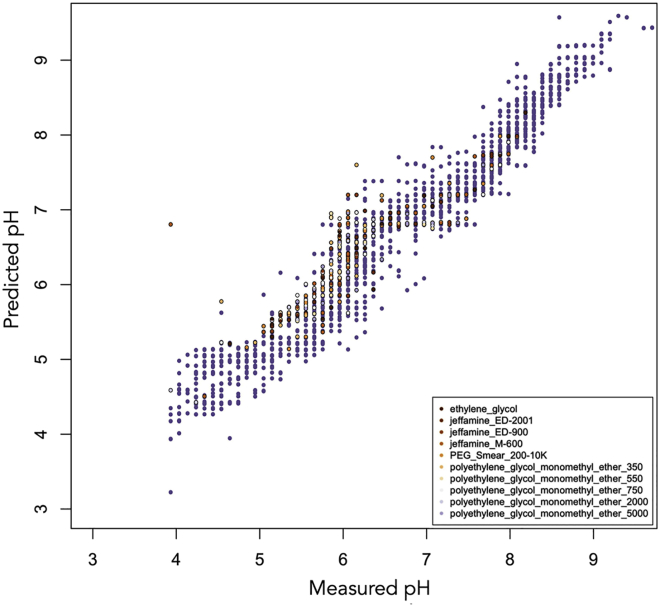
Predicted pH Values Plotted against the Measured pH for Wells Containing PEG MME, Jeffamine, or a PEG SmearThe pH values were predicted using the model obtained using data from wells containing the PEGs shown in Figure 3, plotted here in lavender.